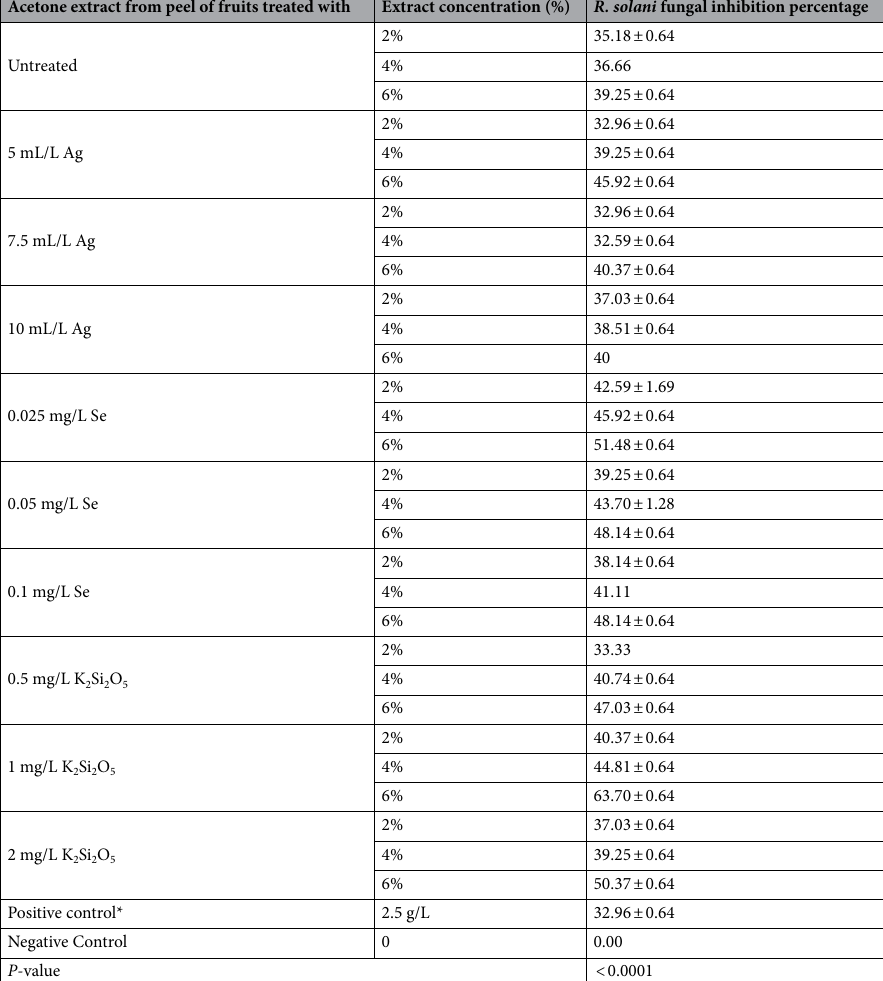
Table 10. Antifungal activity of acetone extracts from peels of pomegranate fruits collected from trees sprayed with different nanomaterials against the growth of R.